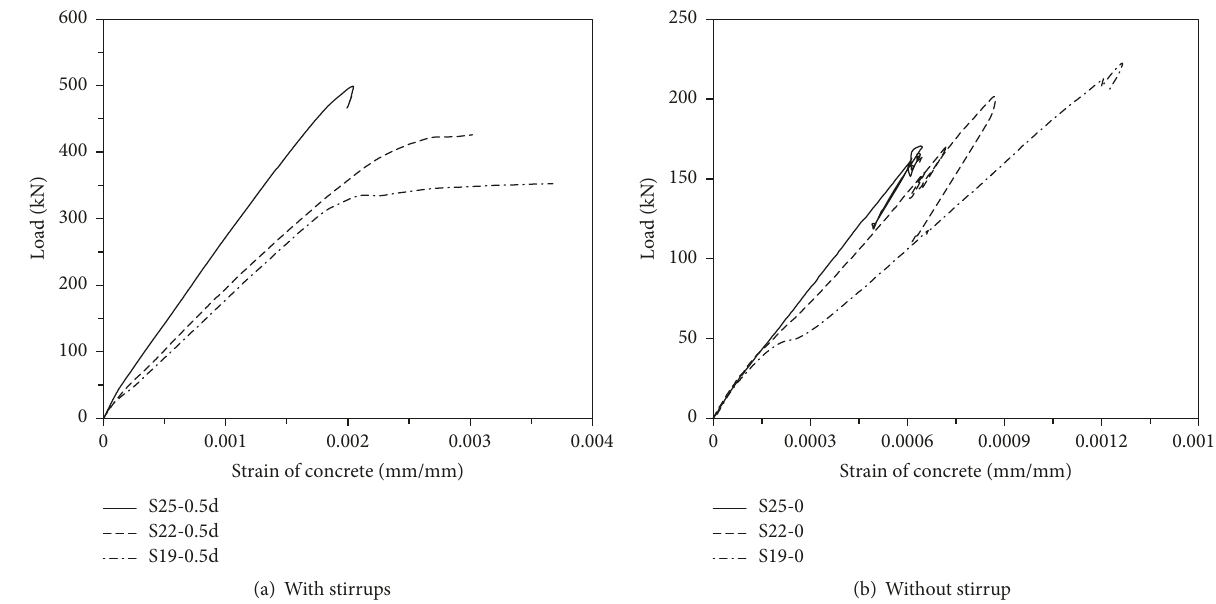
Figure 10: Load versus flexural compressive strain of concrete in shear test specimens.